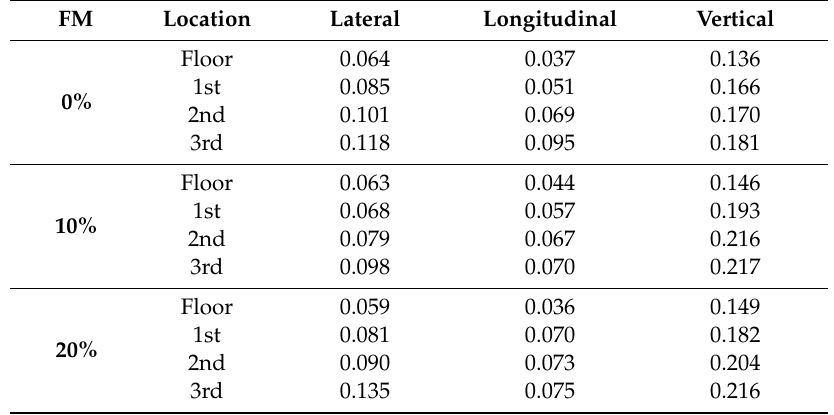
Figure 8. Distributions of vertical acceleration records from this study for ( a – d ) FM 0%, ( e – h ) FM 10%, and ( i – l ) FM 20%. 3.4. Limitations We want to call attention to the fact that the PSD method using the fast Fourier transformation (FFT) process results in a PSD plot with averaged intensity over the observed frequency range of interest. So, the presented PD levels do not expose some severe or extreme vibration levels that can